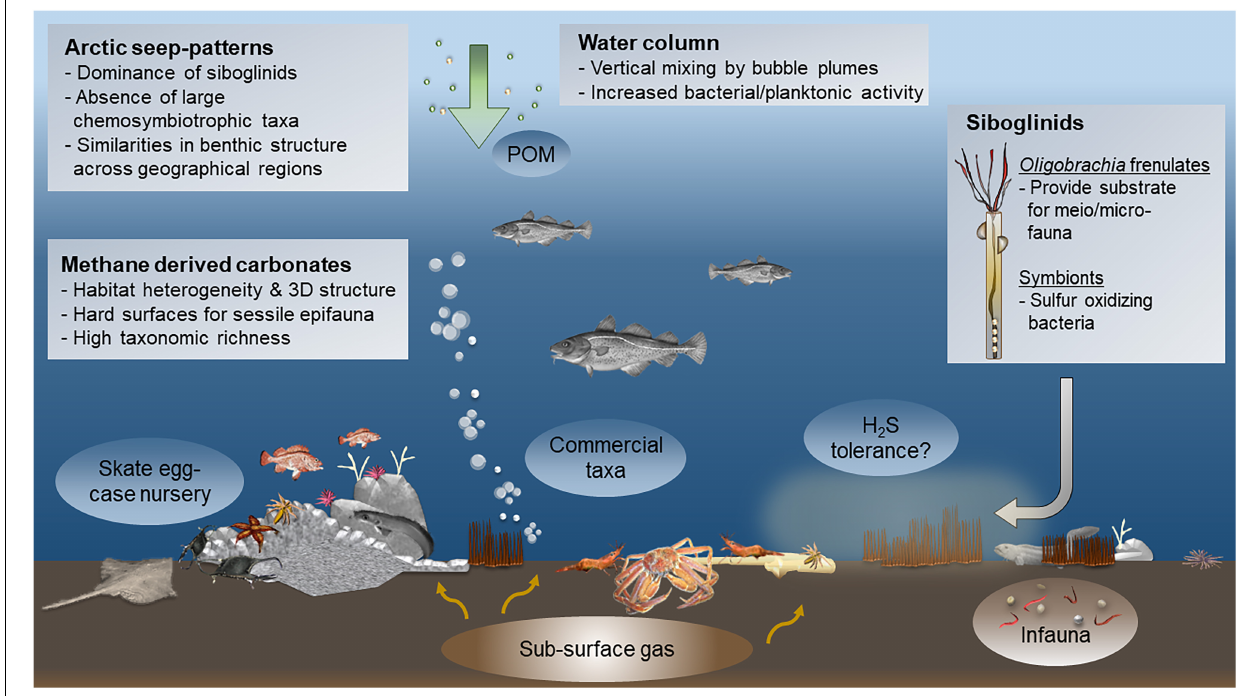
FIGURE 5 | Graphic representation of the key elements of Arctic seeps; a schematic overview of community patterns and characteristics found in Arctic seep habitats. Note that not all patterns are necessarily observed within one single cold-seep site. POM - particulate organic matter.